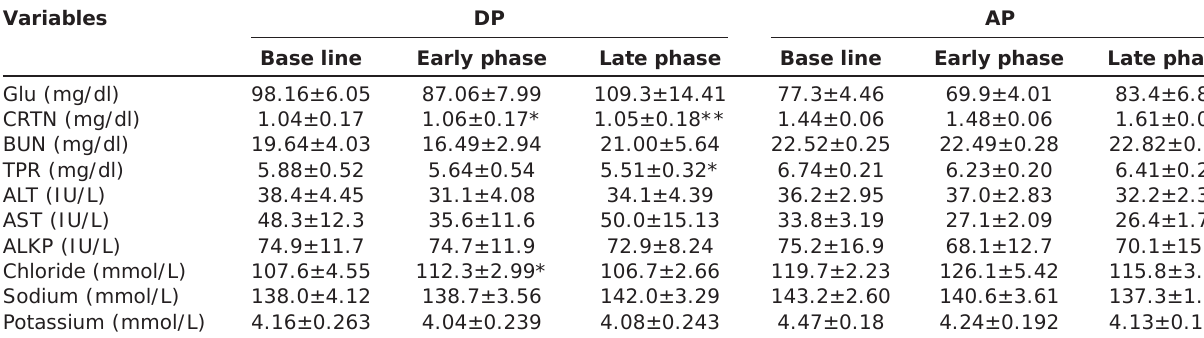
Table-7: Effects of DP (n=10) and AP (n=10) anaesthetic drug combinations on various biochemical parameters during early and late phase of study in dogs (mean±SE).